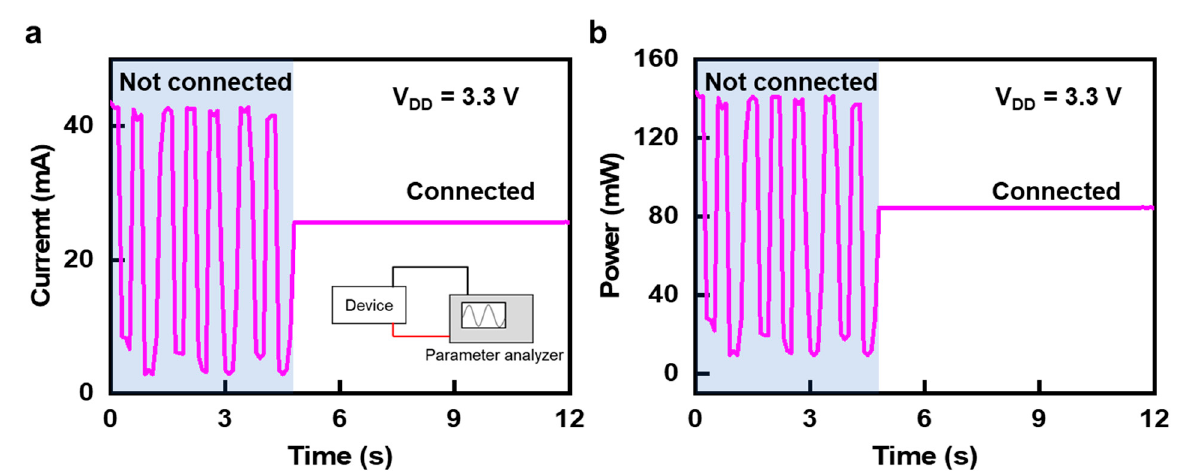
6 of 16 Table 1. Summary of current level and power consumption, corresponding to the microcontroller